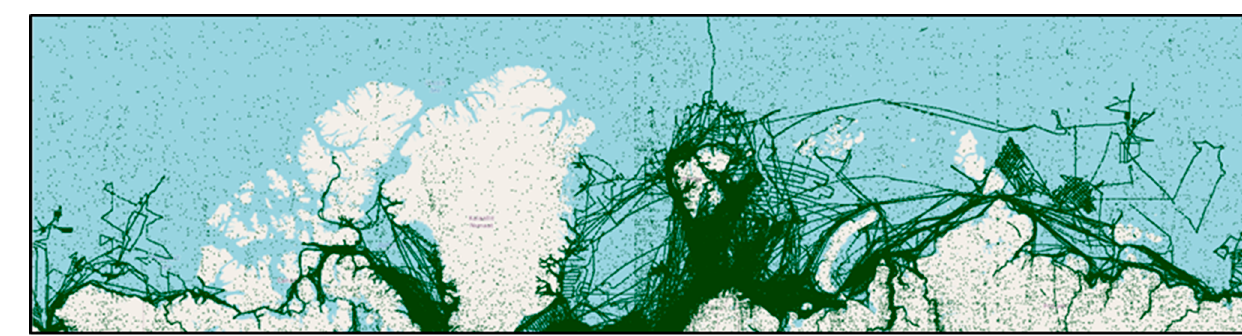
Figure 3. The raw AIS data in the Arctic Ocean.